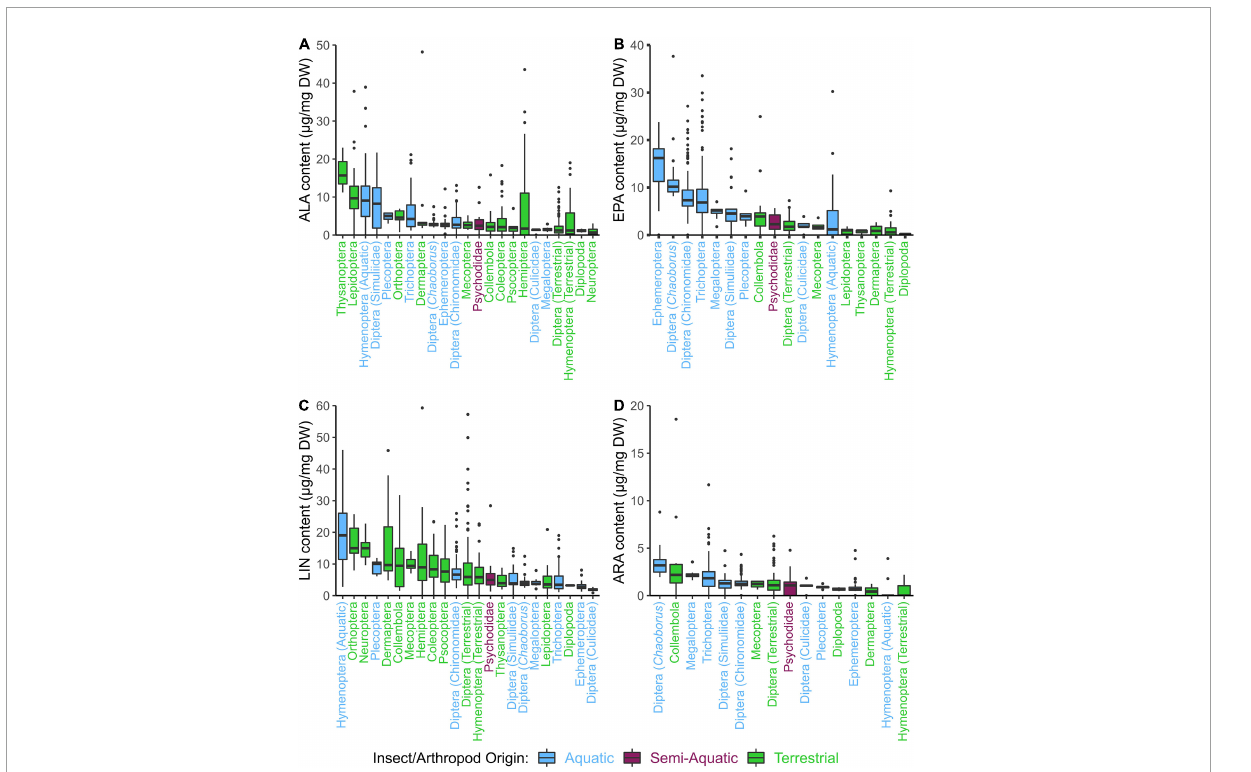
FIGURE5 Contents ( µ g mg − 1 DW) of selected PUFA of aquatic, semi-aquatic, and terrestrial arthropod orders: (A) α -linolenic acid (ALA; 18:3n-3), (B) eicosapentaenoic acid (EPA; 20:5n-3), (C) linoleic acid (LIN; 18:2n-6), (D) arachidonic acid (ARA; 20:4n-6). The box represents the first quartile to the third quartile with a line representing the median value, and the whiskers represent the minimum and maximum value. Only taxonomic groups with a minimum of 3 samples for boxplot statistics were